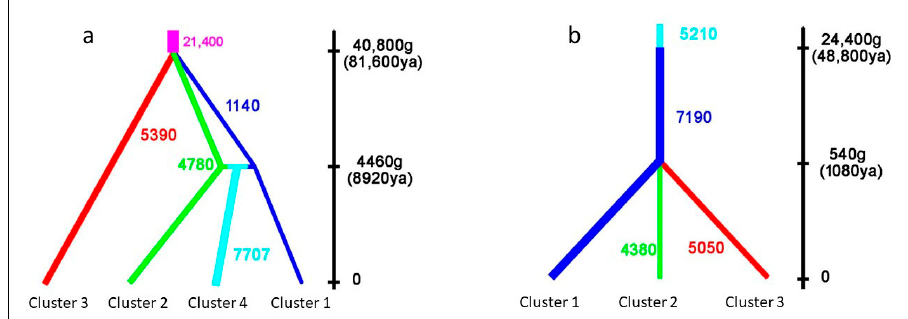
Figure 5. Graphical representation of the resulting population sizes and divergence times estimated for the two best-simulated scenarios inferred by ABC simulations, using a generation time g = 2 years. The width of branches is proportional to the inferred effective population sizes. ( a ) The best scenario was inferred using lineage W haplotypes. ( b ) The best scenario was inferred using lineage DW (lineage D pruned by domestic cats) haplotypes. Cluster numbers refer to the best K repartition obtained by SAMOVA analyses for each of the two lineages.